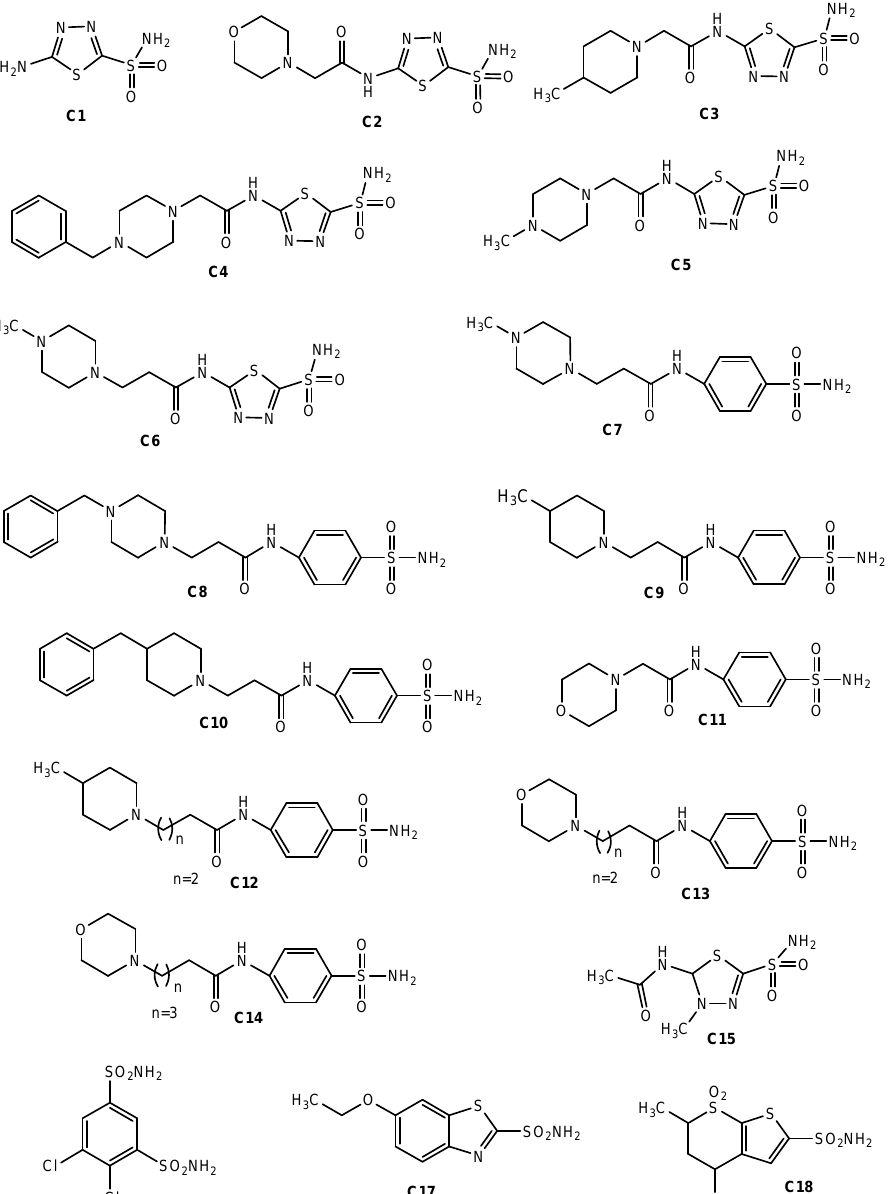
Figure 1. Structural details of compounds used in present study